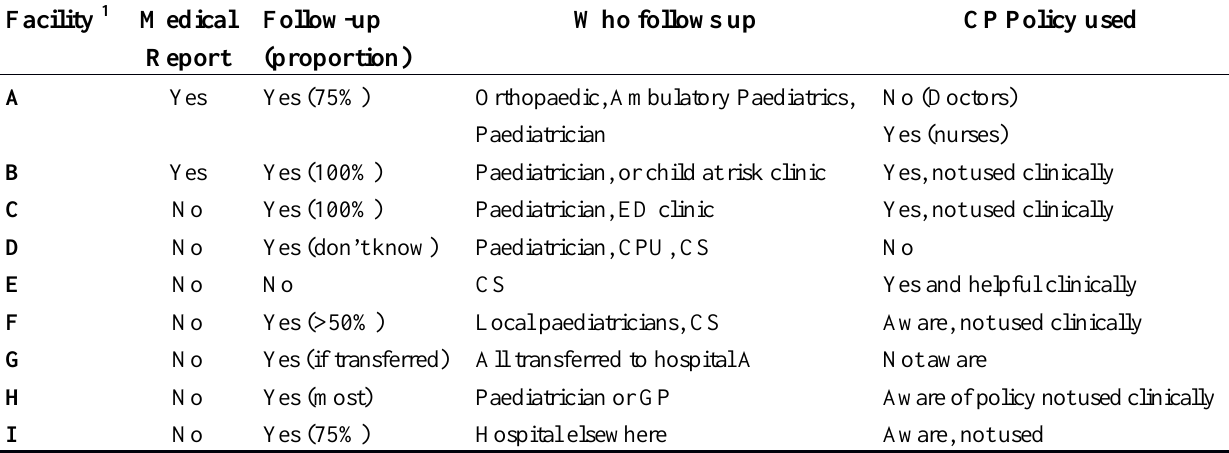
Table 4. Procedures followed after child physical abuse/neglect clinical